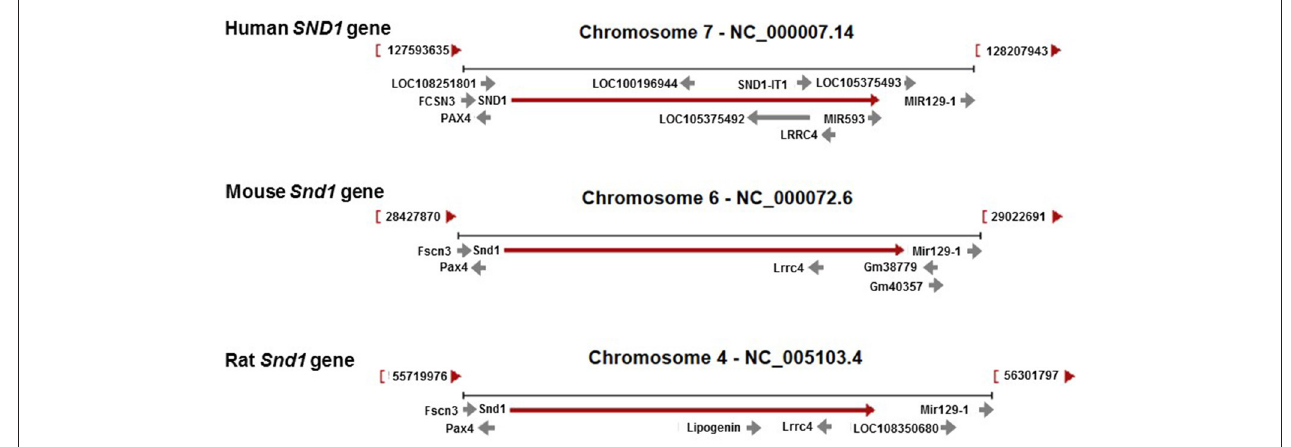
FIGURE 2 | Genomic regions for the human SND1 and the rat and mouse orthologues. Contexts are well conserved in the three species regarding PAX4 , FCSN3 and Mir129-1 . The SND1 gene hosts LRRC4 while the intronic genes MIR593 and SND1-IT1 ( SND1-intronic transcript 1) are present only in the human genome in sense